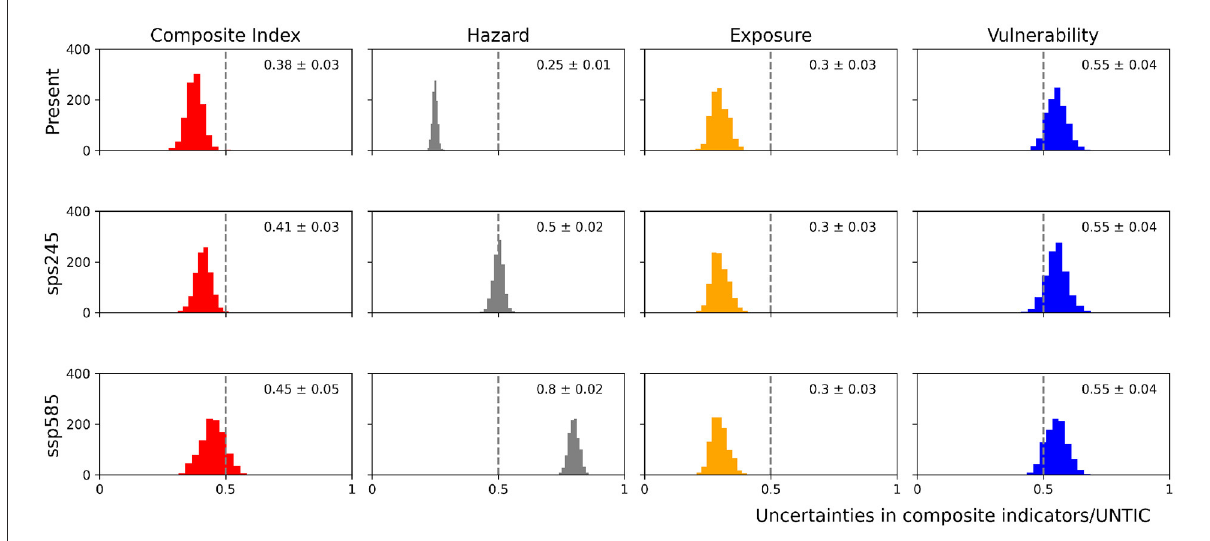
FIGURE5 Probability distribution function for the risk estimate, the hazard, exposure, and vulnerability components under present conditions (top) , SSP245 scenario (middle) , and SSP585 scenario (bottom) . The mean and the standard deviation are indicated in the